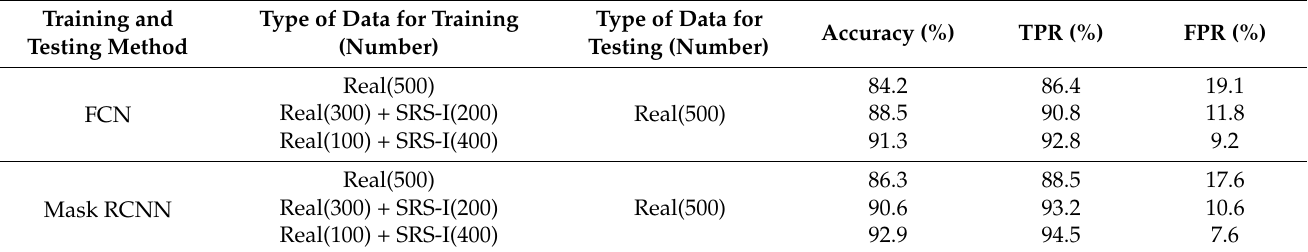
Table 1. Test results of similar data sets.